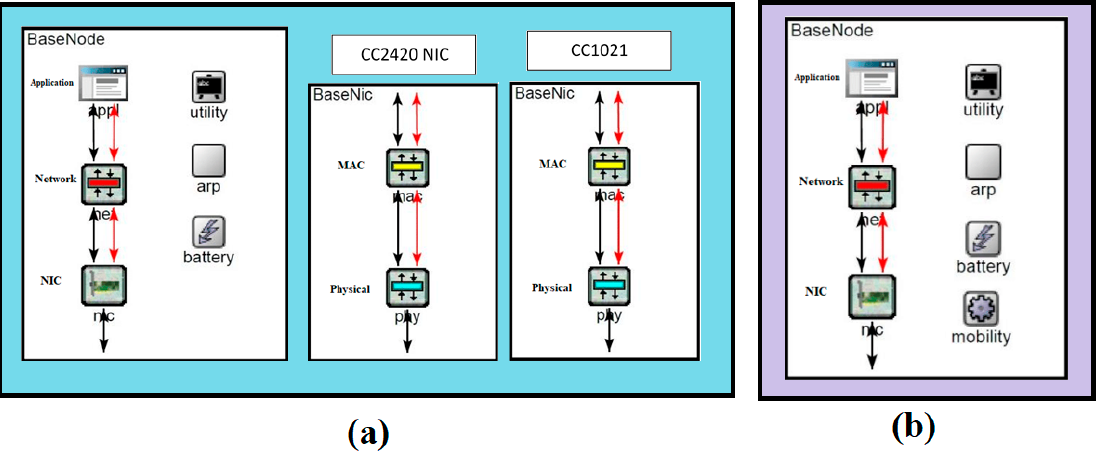
Figure 9. Developed OMNet++ simulation model ( a ) Sensor node simulation model ( b ) Mobile sink extra module other than sensor node model.